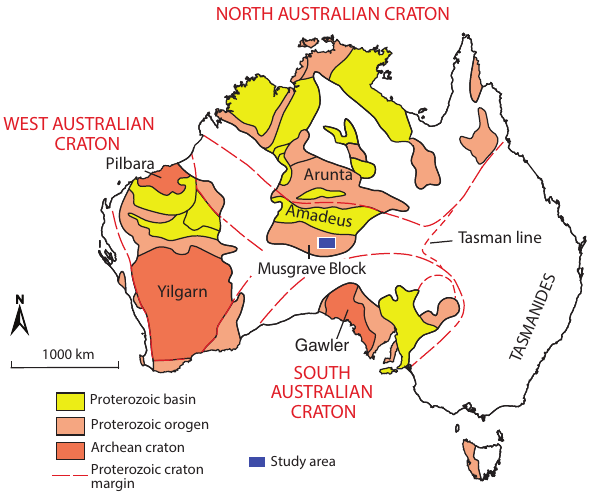
Figure 1. Position of the Musgrave Block between the Archean cra- tons of Australia. Modified after Evins et al.